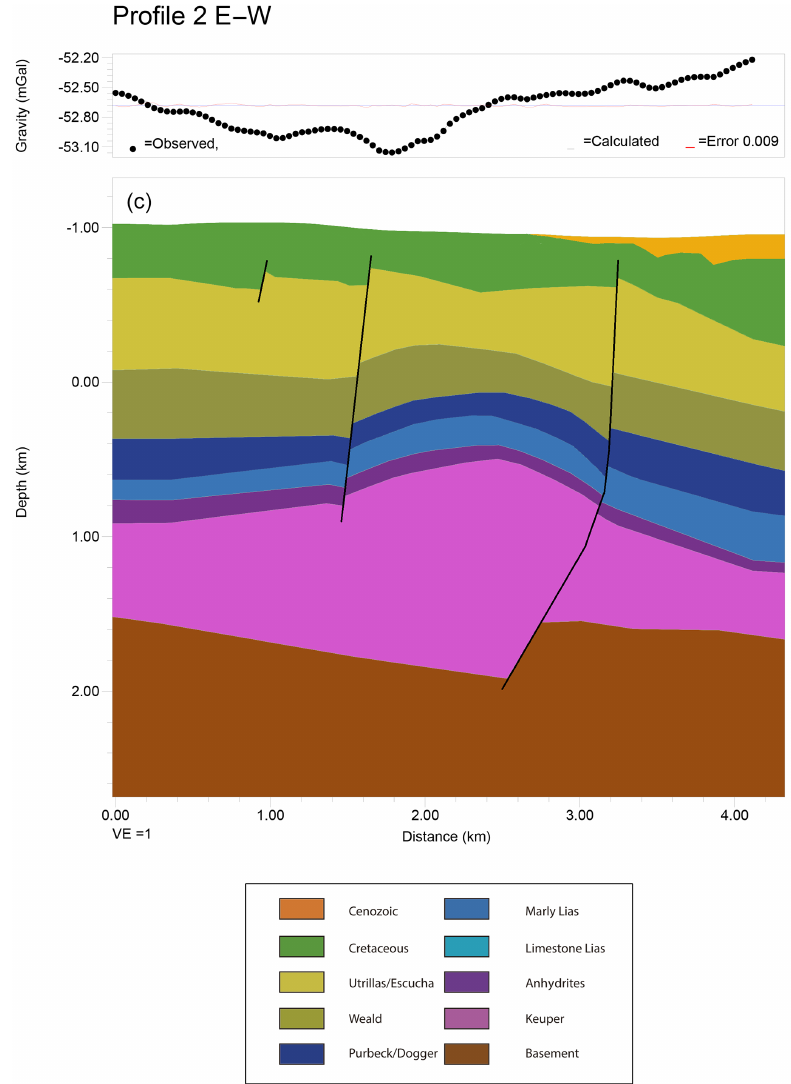
Figure 5. (a) Initial 2-D gravity Model 1 and (b) approximate corresponding two-way travel time seismic section (after Alcalde et al., 2014) both sections are crossed by faults south and east (marked as bold lines in the figure). Note that the offsets of the east fault are opposite in (a) and (b) . The seismic section is interpreted down to the top of the anhydrite unit, marking the beginning of the evaporitic layers. (c) 2-D gravity model striking in an almost W–E direction (see Fig. 3 for location). For colour key see Fig.